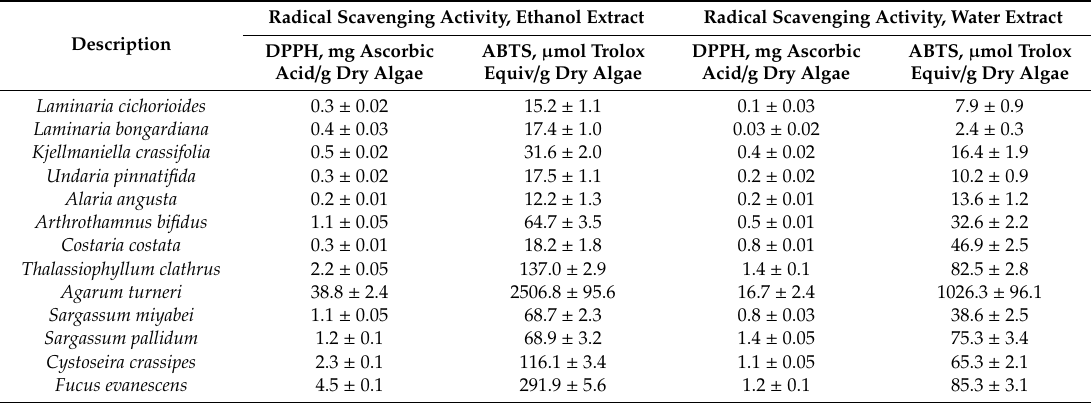
Table 2. Radical scavenging activity of water and ethanol extracts from various algae species.